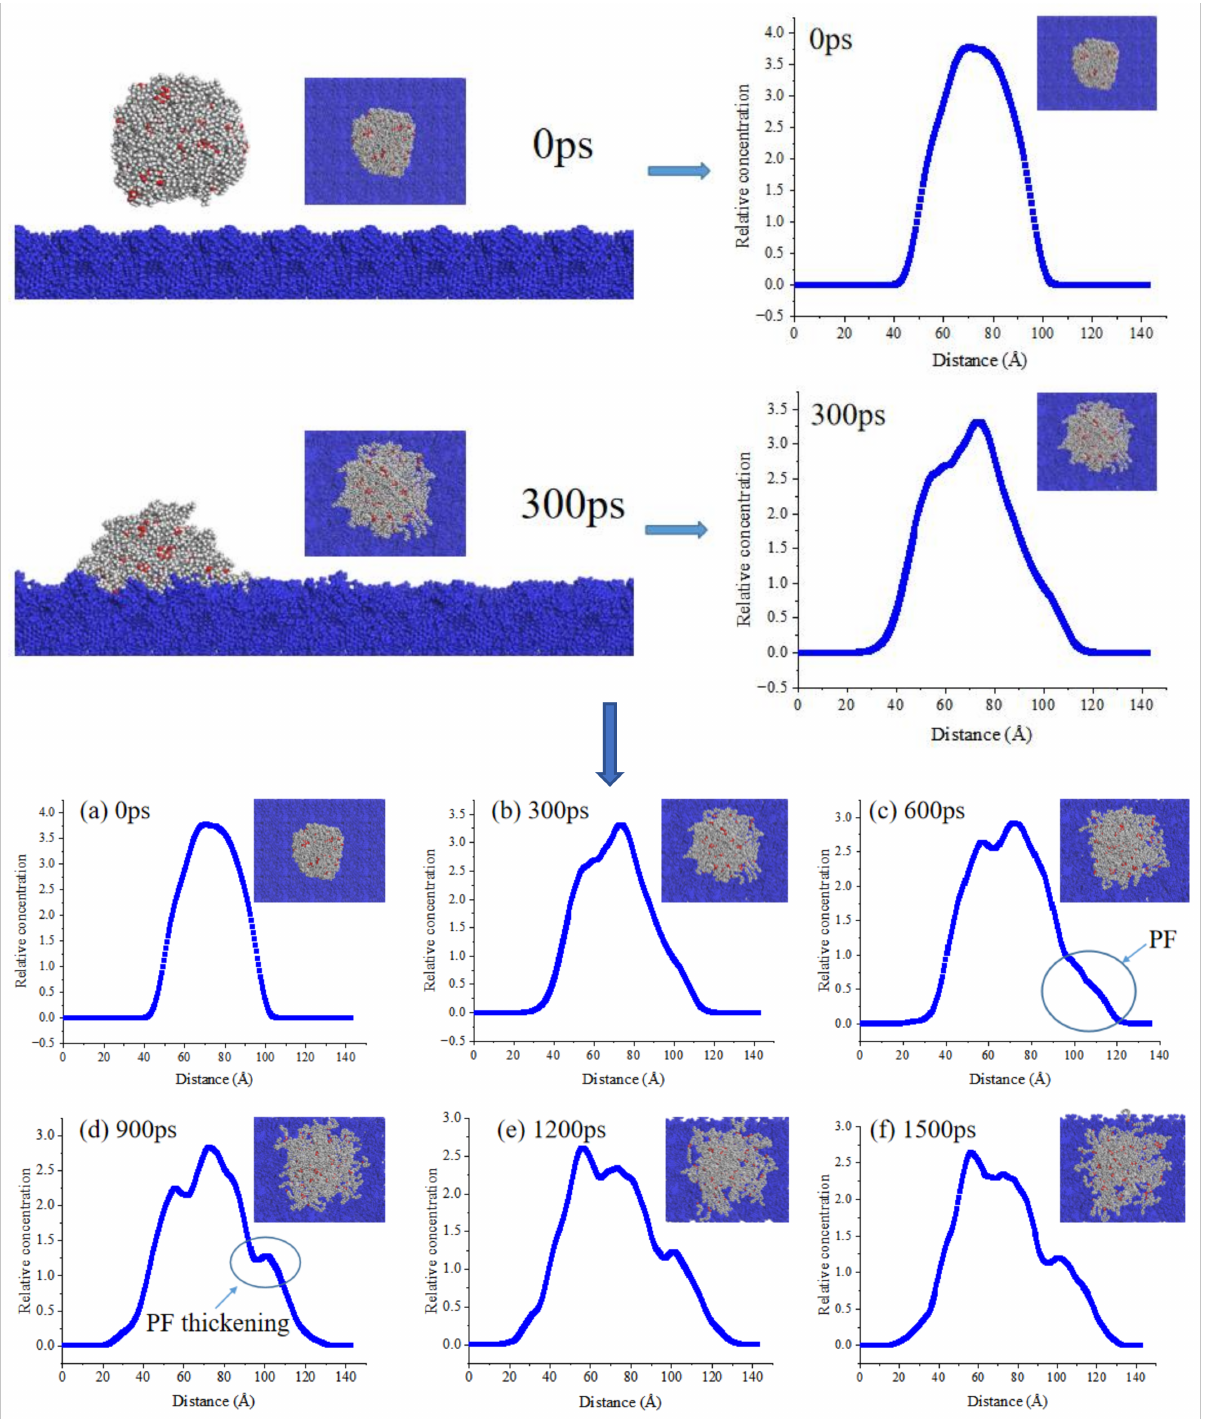
Figure 11. Side and top views of WCO droplet structure evolution. Note: blue block represents bitumen subgrade, blue line represents WCO droplet concentration